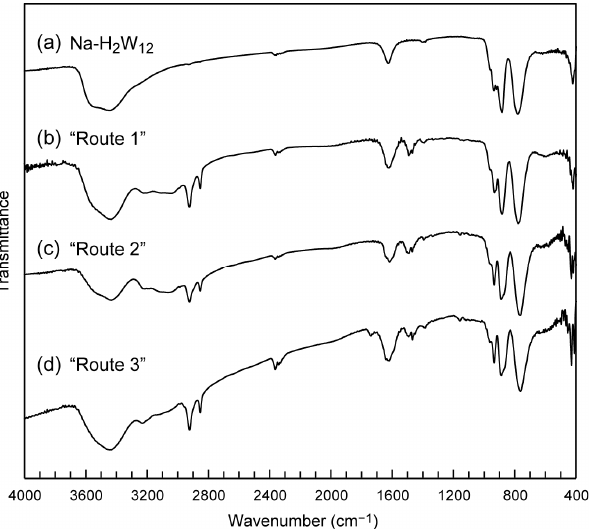
Figure 2. IR spectra of C 12 N 2 -H 2 W 12 hybrid crystals: ( a ) starting sodium salt of H 2 W 12 (Na-H 2 W 12 ); ( b ) colorless precipitate of C 12 N 2 -H 2 W 12 obtained using “Route 1”; ( c ) colorless crystals of C 12 N 2 - H 2 W 12 obtained using “Route 2”; and ( d ) colorless crystals of C 12 N 2 -H 2 W 12 obtained using “Route 3”.